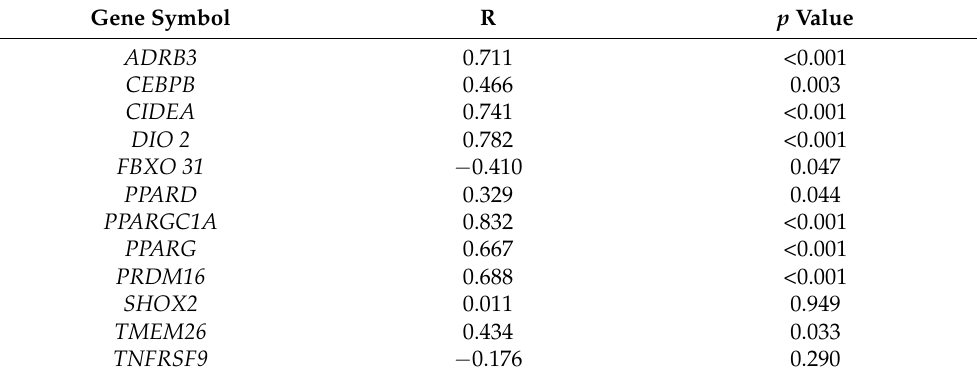
Figure 1. Correlation analysis between UCP1 expression and plasma normetanephrine, plasma norepinephrine, HDLc levels and BMI. Table 4. Complete correlation analysis between mRNA expression of UCP1 and other genes in VAT of patients with